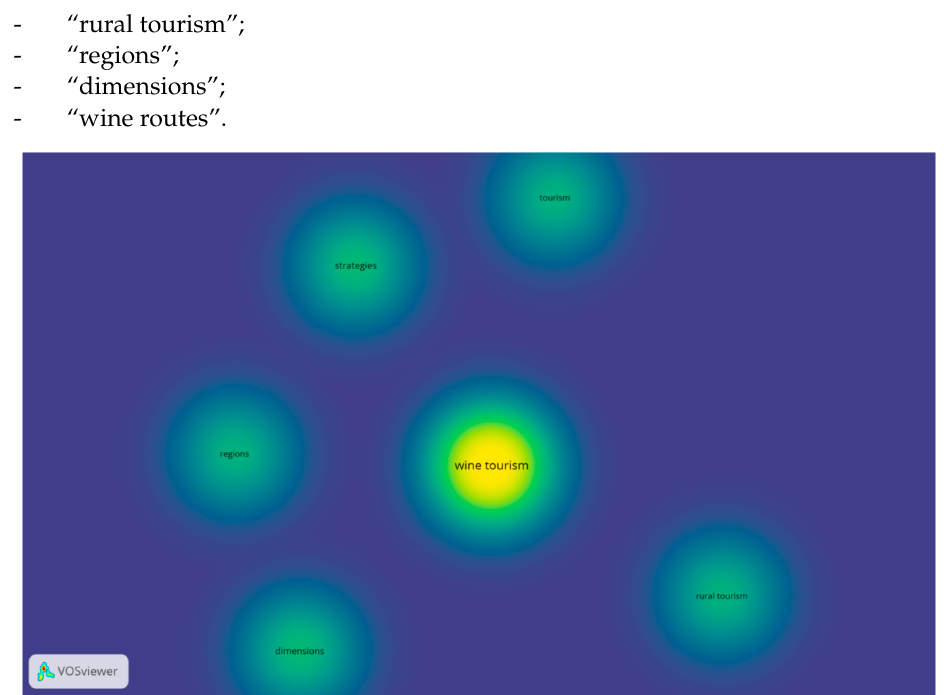
Figure 2. Major keyword clusters related to wine tourism in the most cited WOS articles from 2019–2023.